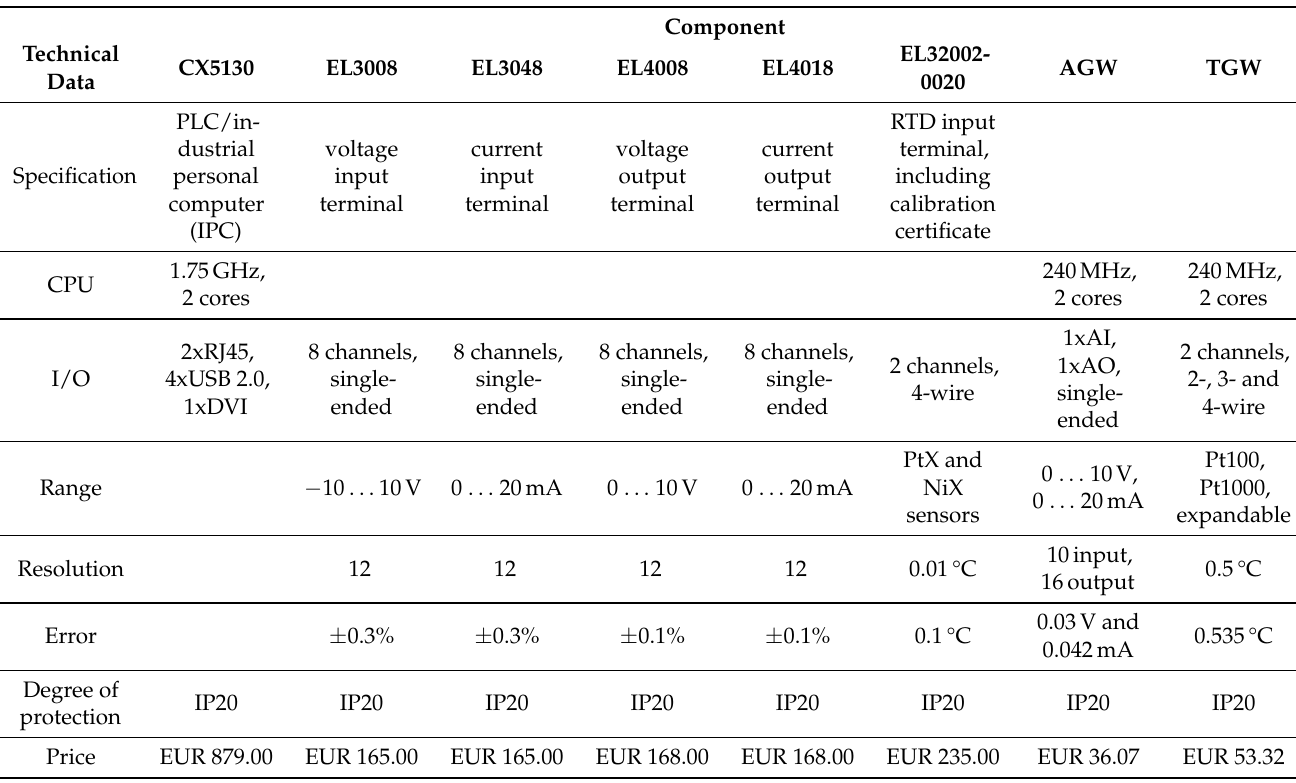
Table 3. Comparison of the technical data and prices of the Beckhoff ® PLC components and the gateways used in the performance analysis. The Beckhoff ® components were ordered in